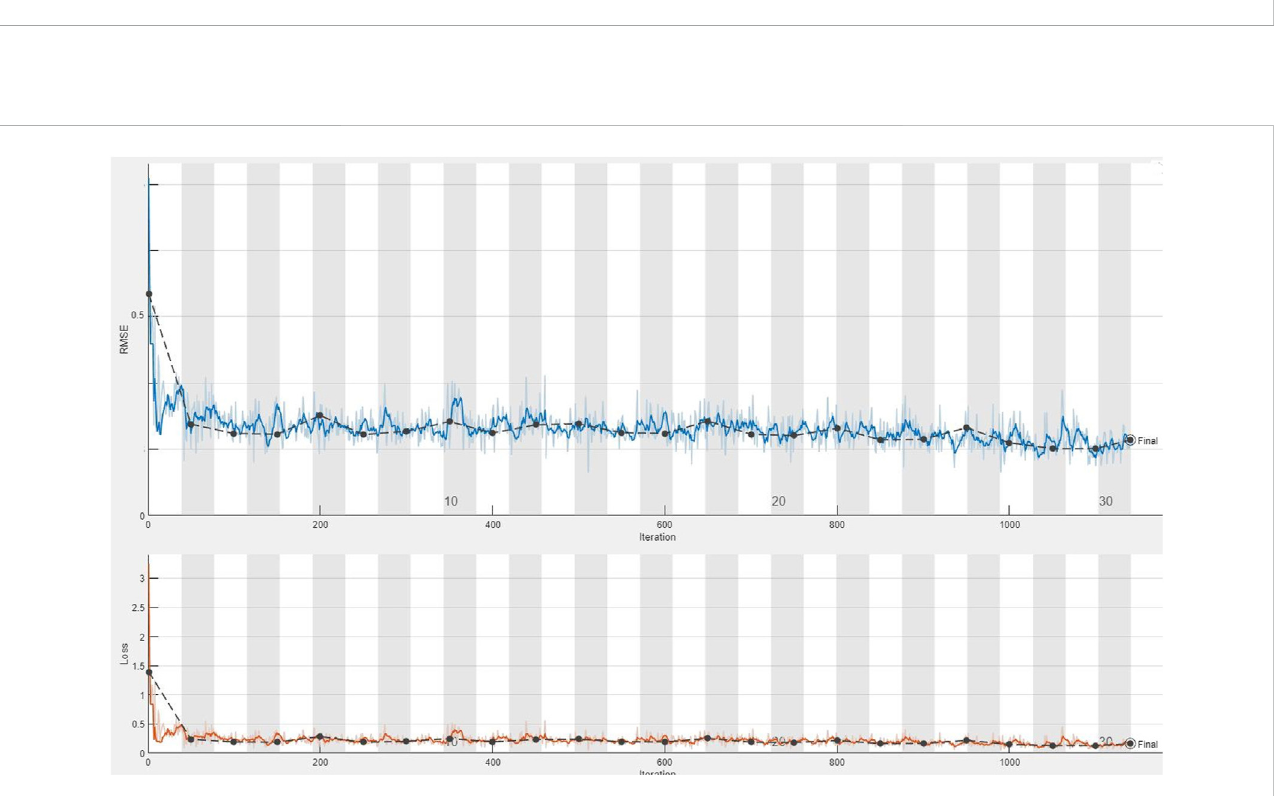
FIGURE 3 Plot of the running CDL network for clustering the fi rst group of geochemical indicator elements (Pb – Zn); (A) training data and (B) testing